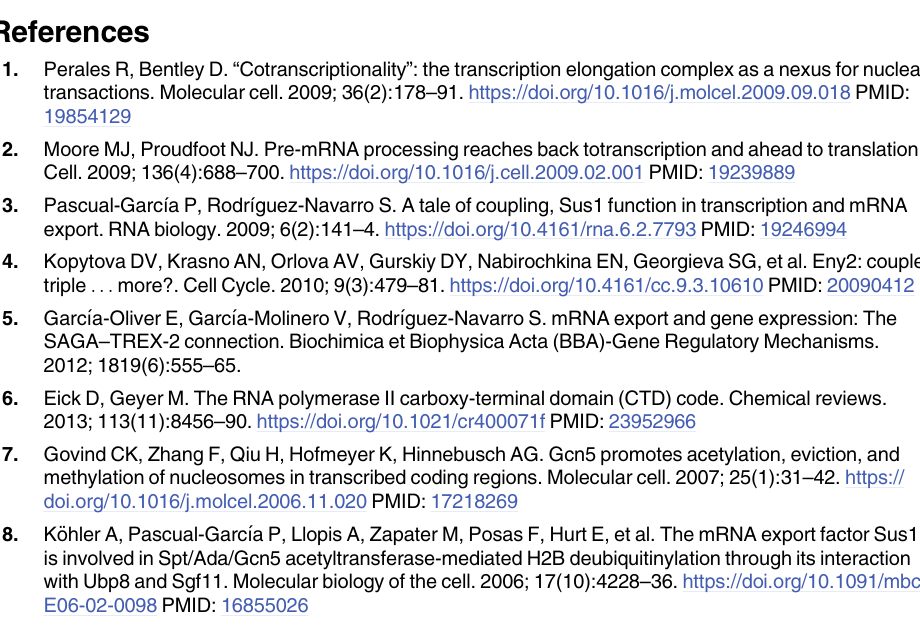
S1 Fig. pH-dependent alteration in MRE. Mean residue ellipticity value (MRE) of the far UV-CD of Sus1 at 222 nm and 208 nm was plotted at different pH. MRE value at 222 nm and 208 nm is represented by filled square ( ■ ) and open circle ( � ) respectively. S2 Fig. pH changes don’t affect the oligomerization of Sus1. AKTA profile of Sus1 at differ- ent pH. AKTA profile at pH7, pH5 and pH2 is represented by the closed circle (•), closed trin- gle ( ▲ ) and open circle ( � )